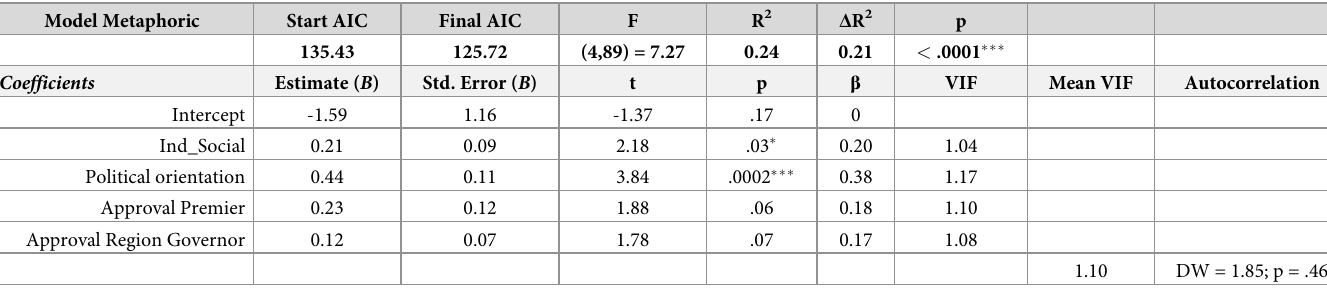
Table 3. Multiple regression statistics of the metaphoric